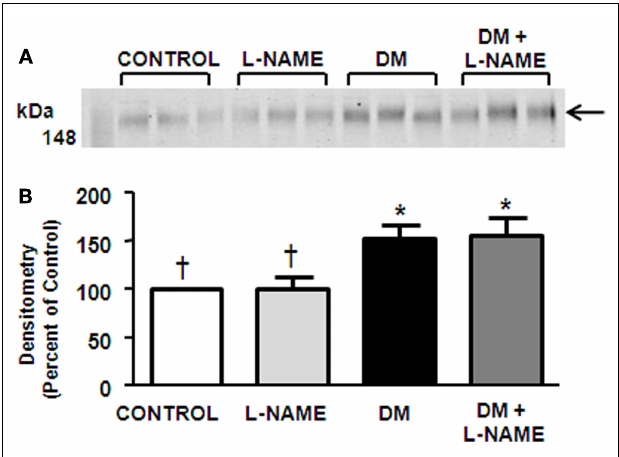
FIGURE 4 | NO inhibition does not affect NKCC2 expression. Observed is a representative western blot of outer medulla (A) probed for NKCC2. Densitometry was determined (B) .The experimental conditions were performed five times ( n = 5) where there were five animals per experimental group in each cohort. In total, 25 animals per experimental group were analyzed. * p < 0.05 compared to control, † p < 0.05 compared to